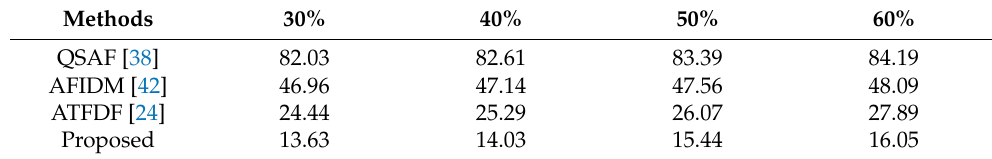
Table 3. Running time consumption comparison (in seconds) for Lena with 30% to 60%